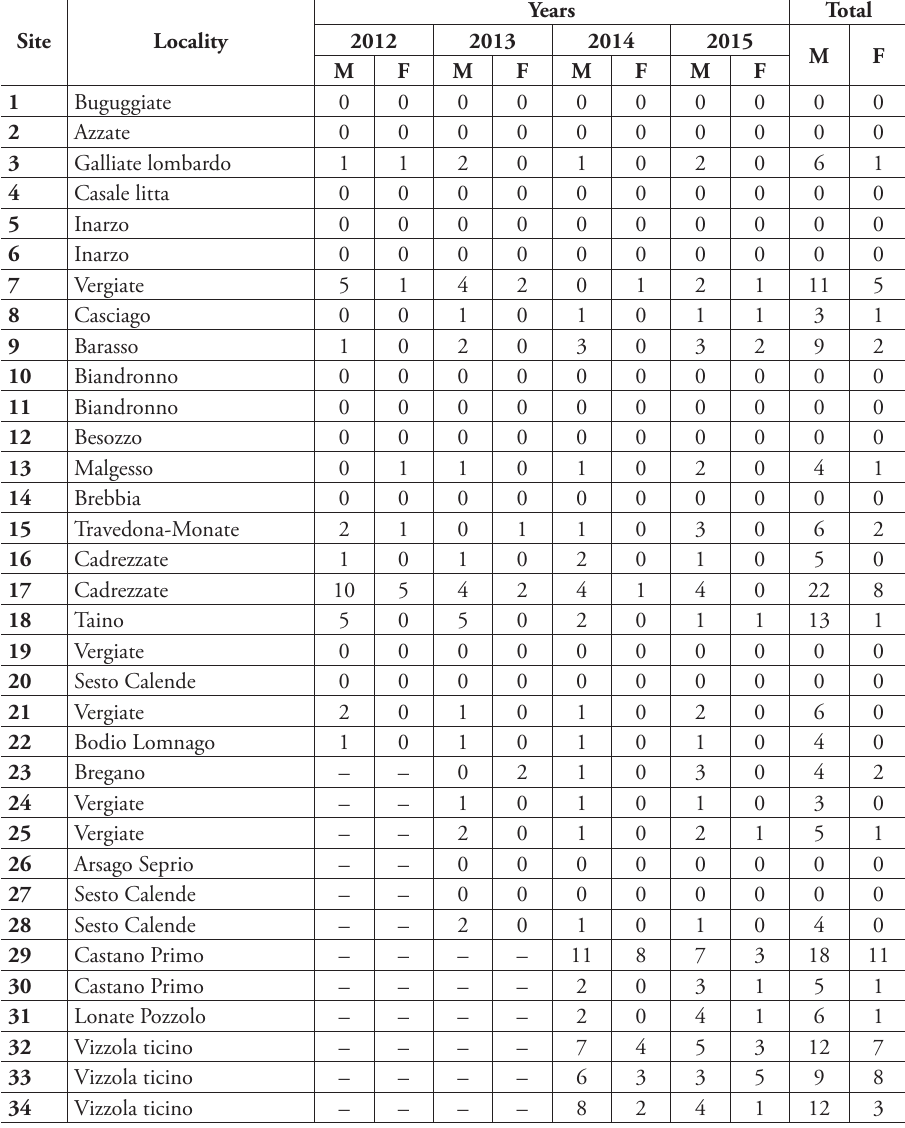
Table 2. Number of specimens collected within the study area in each sampling site from 2012 to 2015. (F= Female; M=